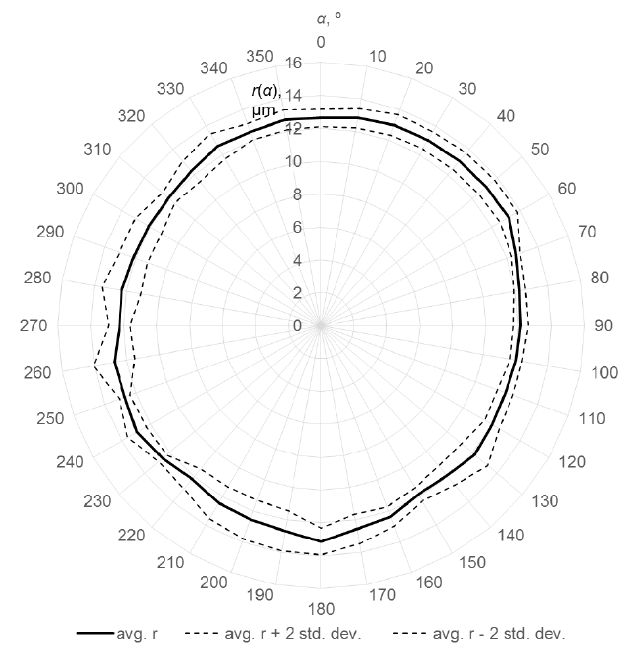
Figure 4. Results obtained in the laboratory for strain gauge probe with a 100 mm stylus.